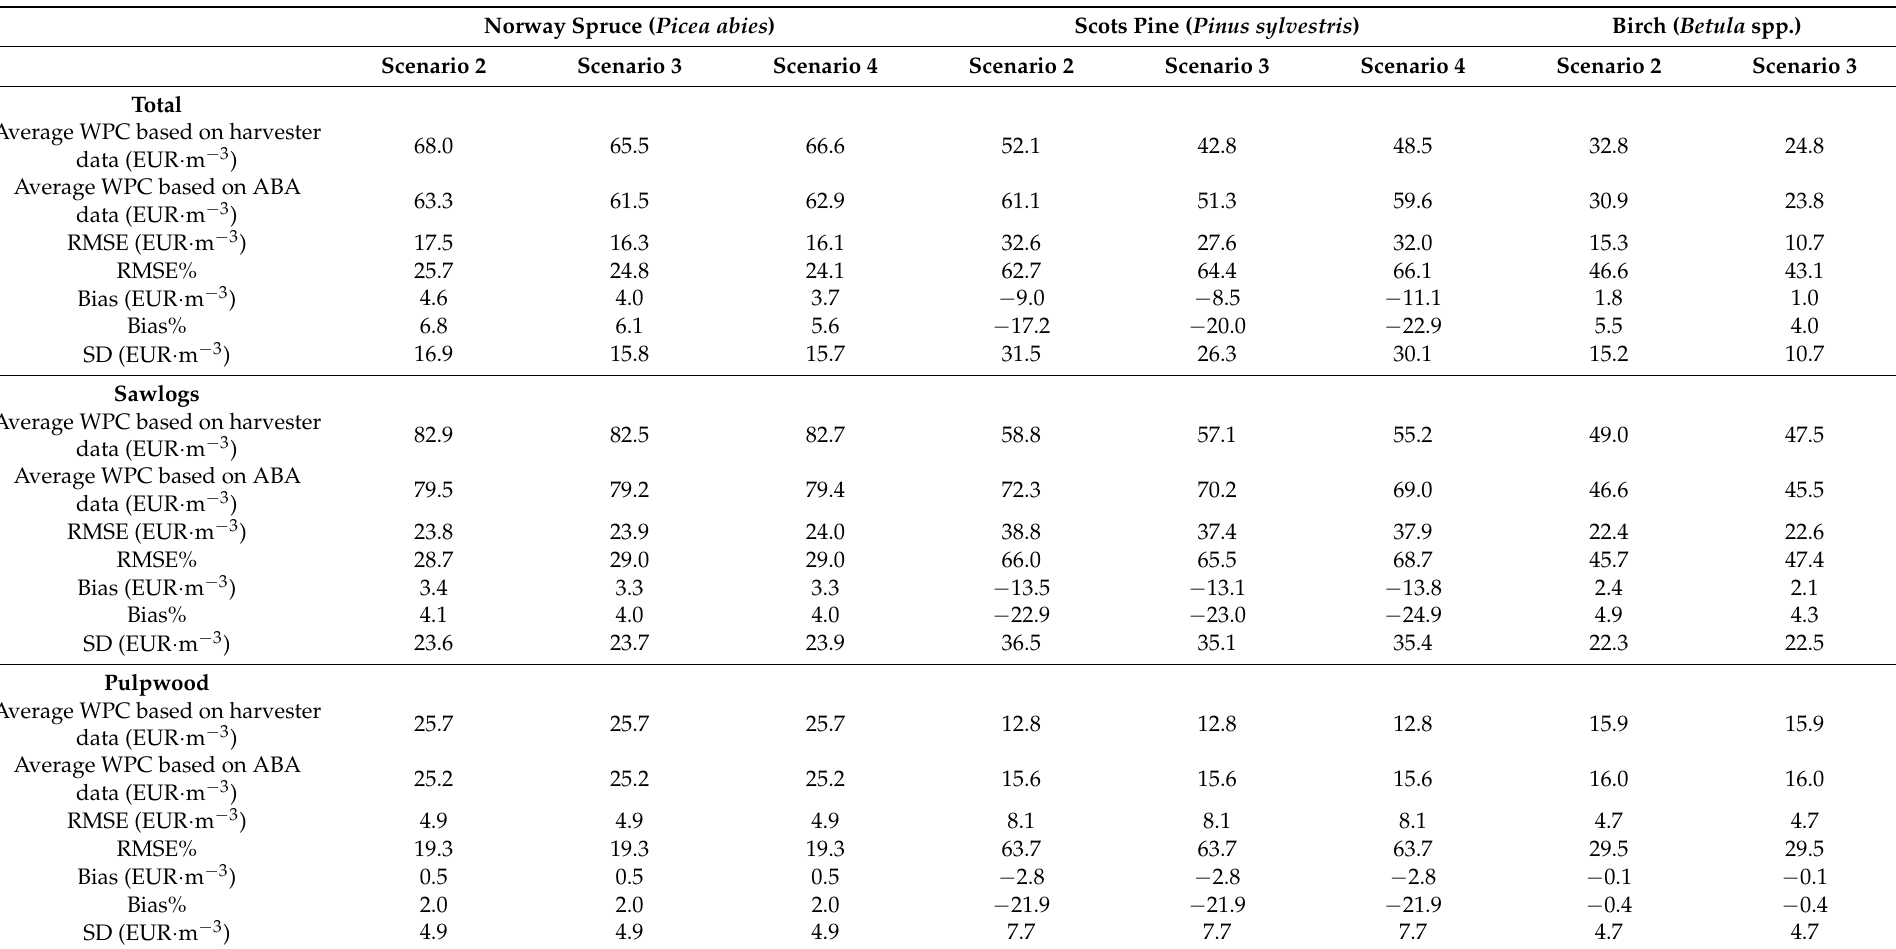
Table 5. Wood paying capability (WPC) estimates for the timber assortments and their error statistics at the stand level ( n = 249 stands). Norway Spruce ( Picea abies ) Scots Pine ( Pinus sylvestris ) Birch ( Betula